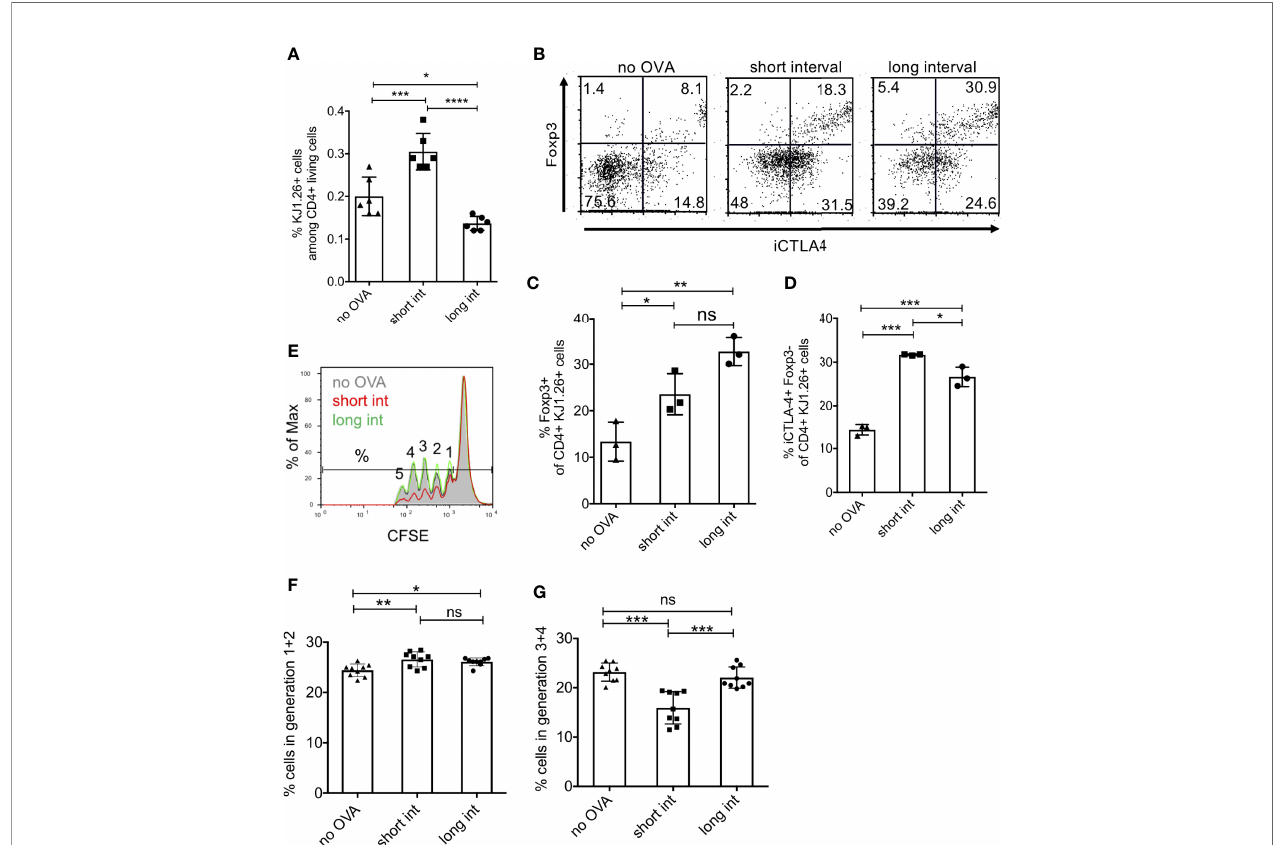
FIGURE 6 | Induction of regulatory T cells is favoured by short interval OVA injection in vivo. DO.11.10 T cells (1x10 7 ) were injected i.v. into BALB/c mice and one day later with a high dose of 400µg OVA protein (Profos, endotoxin-free). Animals were injected a second time with OVA using the same dose and route after 3 days (short interval) or 11 days (long interval). (A) Five days after the last OVA injection FACS analysis was performed to determine the percentage of DO11.10 T cell recovery by KJ1-26 staining among CD4 + living spleen cells, gated as in Figure 5b but without CFSE. (B – D) Representative FACS analysis by staining CD4, KJ1-26, iCTLA-4 and Foxp3 and statistical evaluation of Treg subsets. (E – G) CD4 + splenic T cells of each mouse group were magnetically separated and tested for their suppressive capacity by culturing them with proliferating CFSE-labelled responder CD4 + T cells. (E) Example of CFSE dilution from each animal group. Numbers represent the number of cell divisions. (F, G) Summary of e showing all groups separated into early cell divisions (1 + 2) and later divisions (3 – 5), respectively. (Error bars: SD, Dots represent individual mice. One-way ANOVA with multiple comparisons *p < 0.05, **p < 0.01, ***p < 0.005, ****p < 0.0001). ns, not signi fi